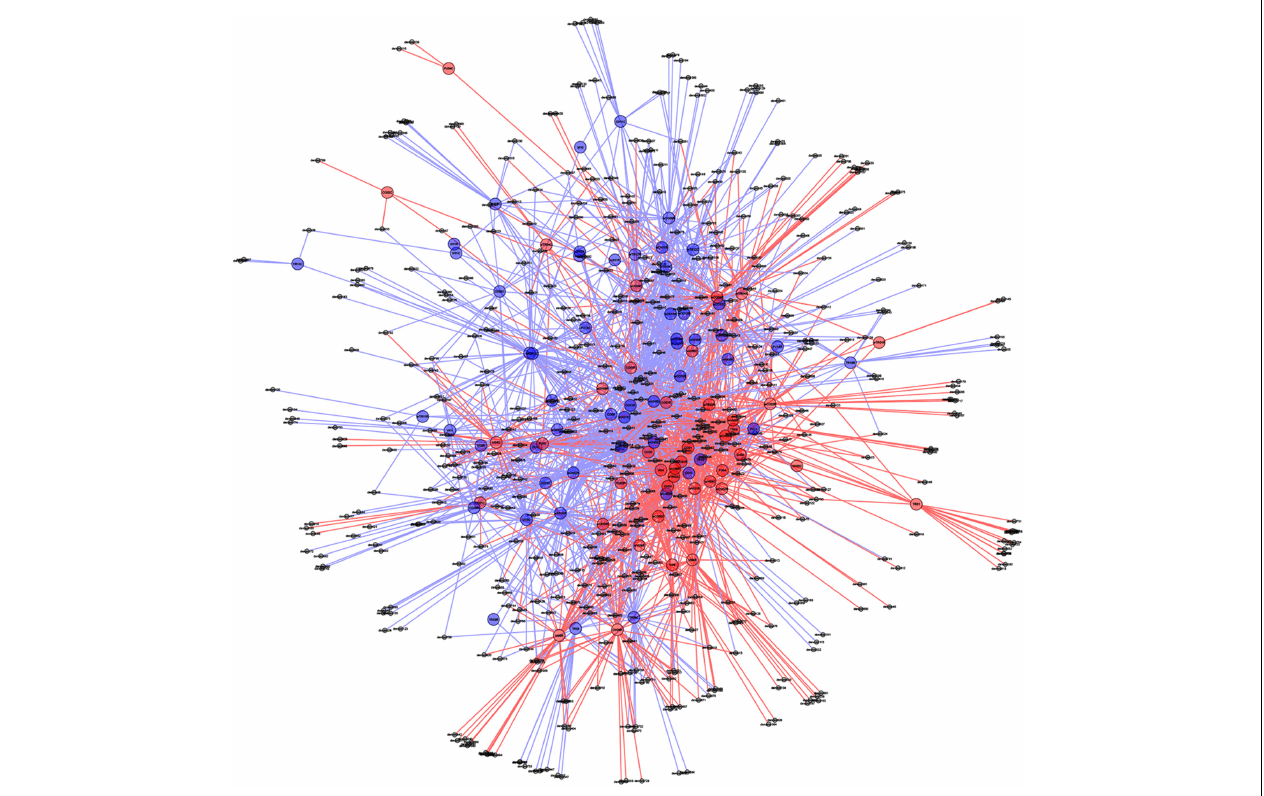
FIGURE 6 | Oomycetes OTU networks in healthy and die-back samples. Larger nodes indicate samples, whereas smaller nodes represent OTUs. All OTUs are connected to the sample to which they belong with a line (edge) making shared OTUs connected to more than one sample. Healthy samples and OTUs as well as lines are indicated with blue, and die-back samples with red. Samples with shared OTUs are located in the center of the plot, while samples with unique OTUs are located in the